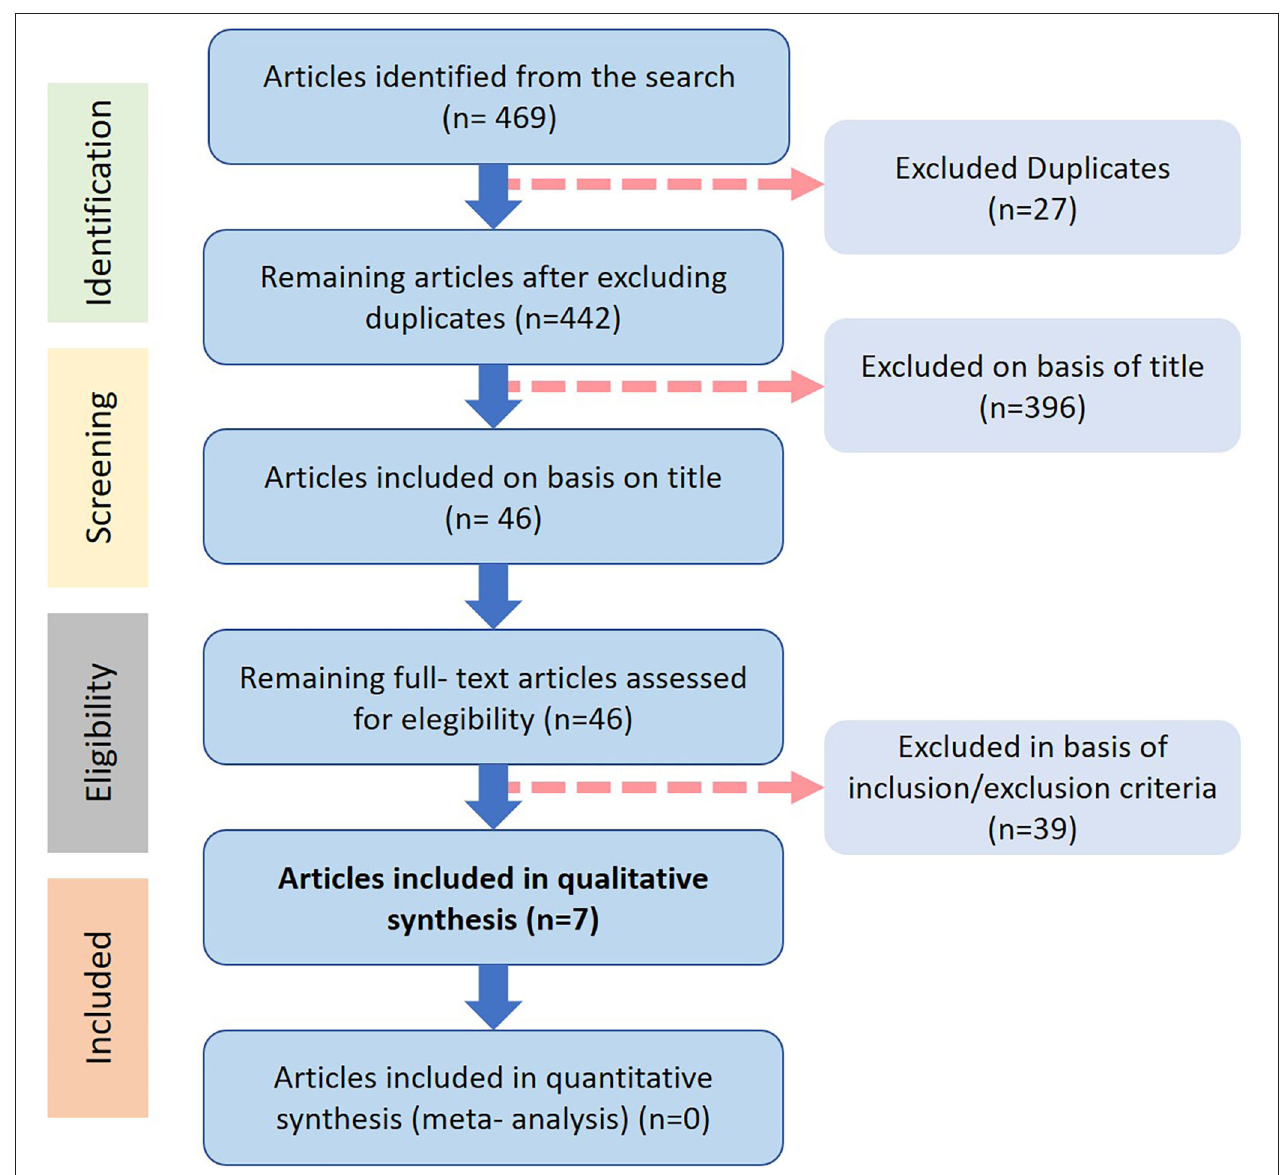
FIGURE 3 | Database search and study selection diagram.